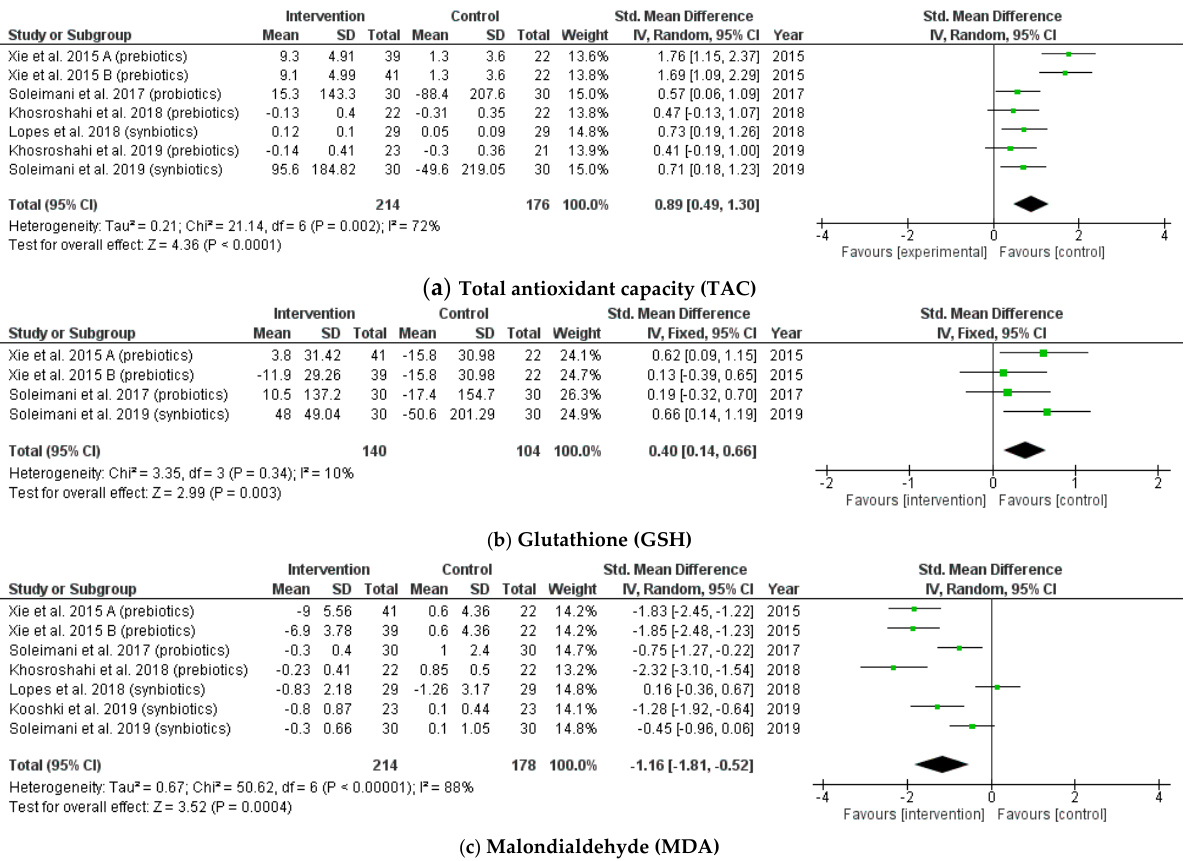
Figure 5. Forest plot for probiotic, prebiotic, and synbiotic effects on oxidative stress status: ( a ) total antioxidant capacity (TAC); ( b ) glutathion (GSH); ( c ) malondialdehyde (MDA) in hemodialysis patients.